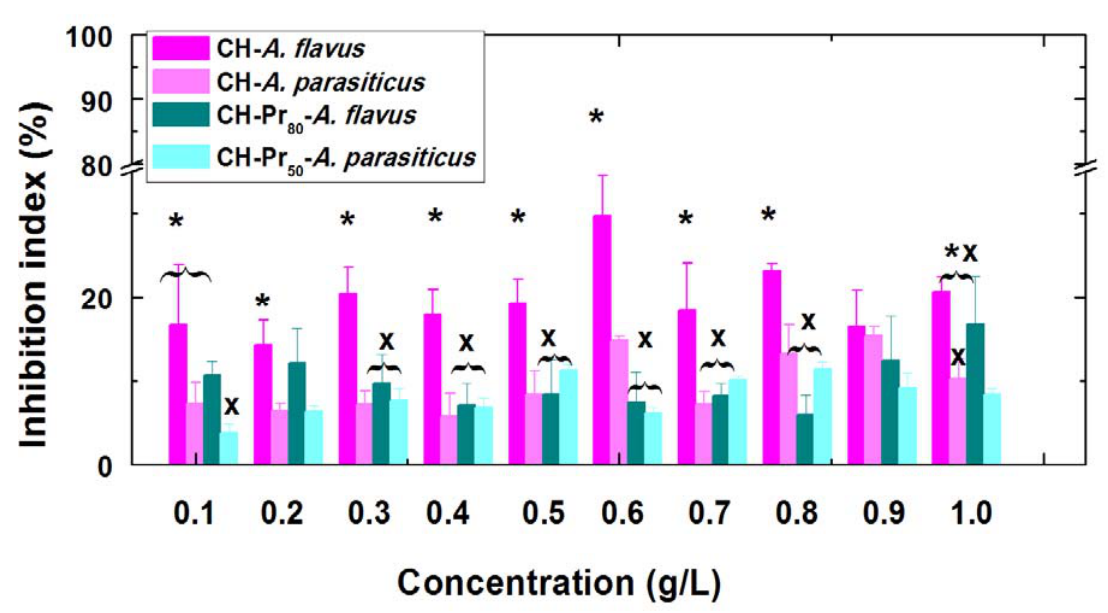
Figure 2. Concentration effect on the inhibition index of deacetylated chitosacn (CH) and its quartenary derivatives (CH-Pr80 and CH-Pr50) against A. flavus and A. parasiticus. Bars within the same concentration with different symbols are significantly different according to Kruskal-Wallis test ( p <